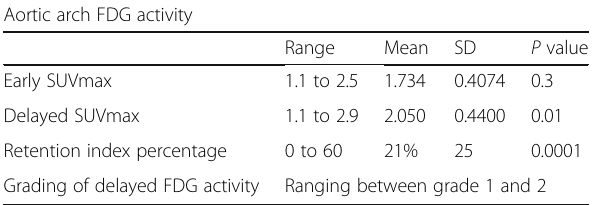
Table 5 Aortic arch FDG dual point quantitative parameters in the 50 patients of study population